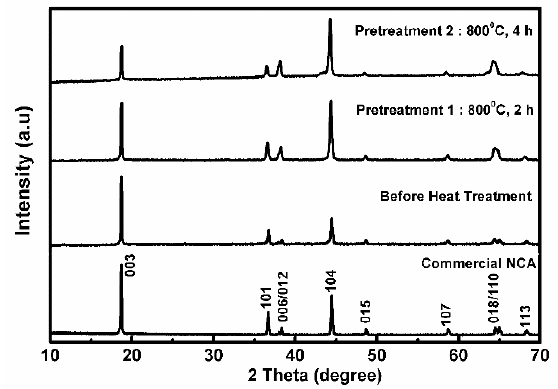
Figure 2. XRD pattern of NCA powder before heat treatment (B-HT) and after heat treatment at 800 ◦ C for 2 or 4 h (P-01 and P-02 samples).